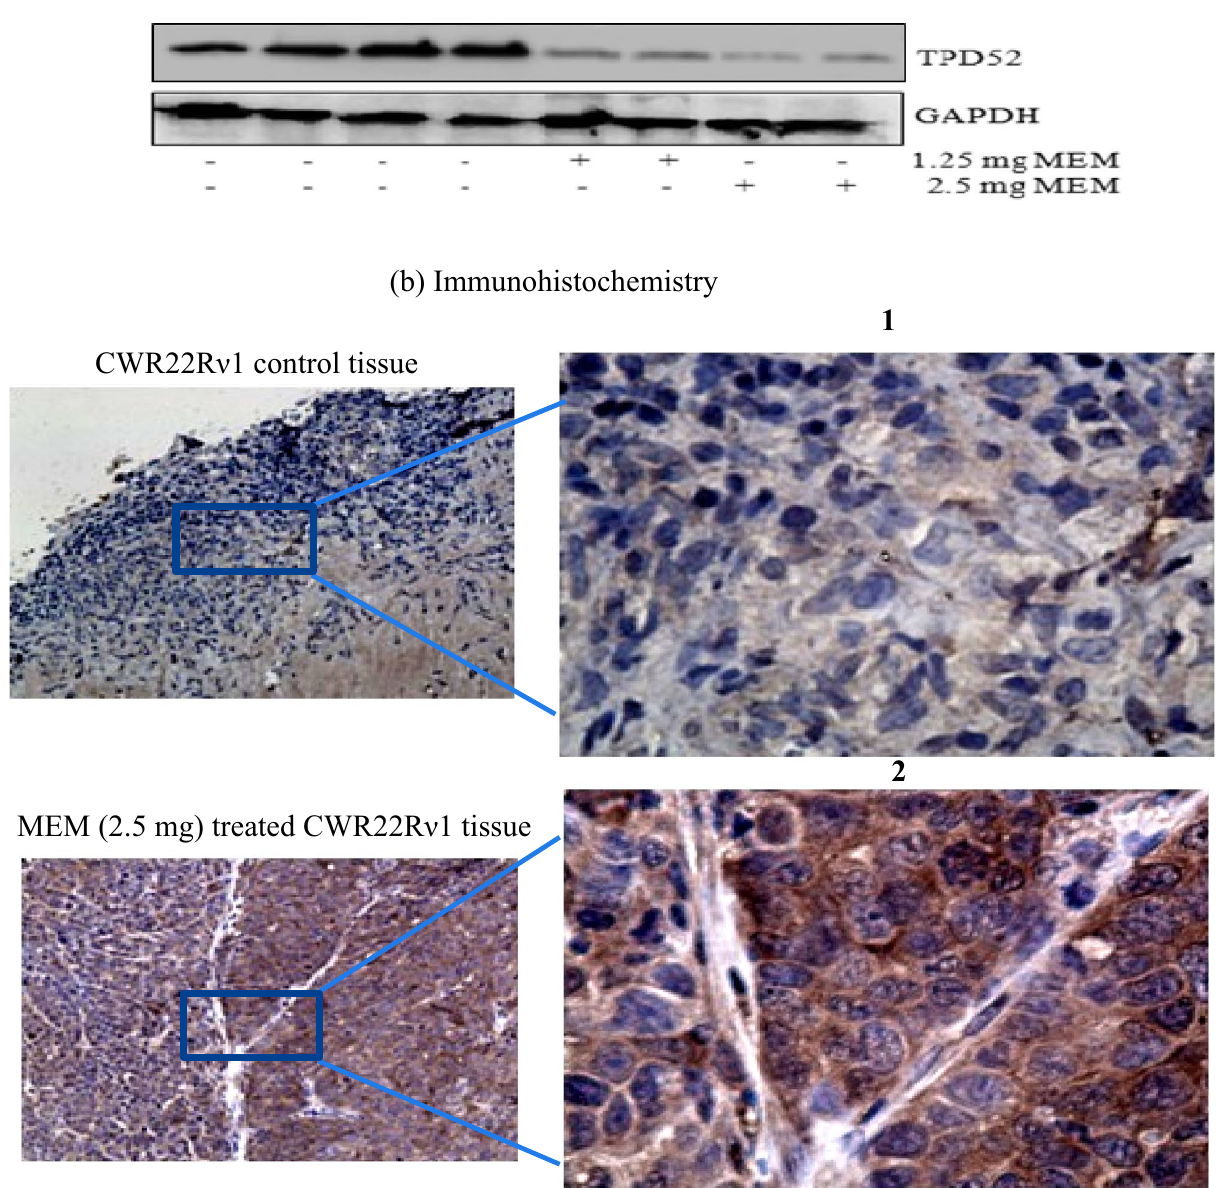
Figure 7. Validation of TPD52 expression in CWR22Rν1 xenograft tissues in athymic nude mice and the effect of MEM treatment on TPD52 expression. ( a ) Immunoblot analysis of TPD52 expression CWR22Rν1 xenograft tissues in MEM treated group as compared to the control group. The total cell lysate was prepared and 40 μg protein was subjected to SDS-page followed by Immunoblot analysis and chemiluminescence detection. The blots shown here are representative of three independent experiments with similar results. ( b ) Immunohistochemistry of CWR22Rν1 xenograft tissues demonstrating expression of TPD52 in control (untreated b.1) and MEM (2.5 mg) treated mice (b.2). An intense brown stain of the cytoplasm of control tissues showed high expression of TPD52 as it is cytoplasmic in origin as compared to MEM treated mice tissue where there is no staining